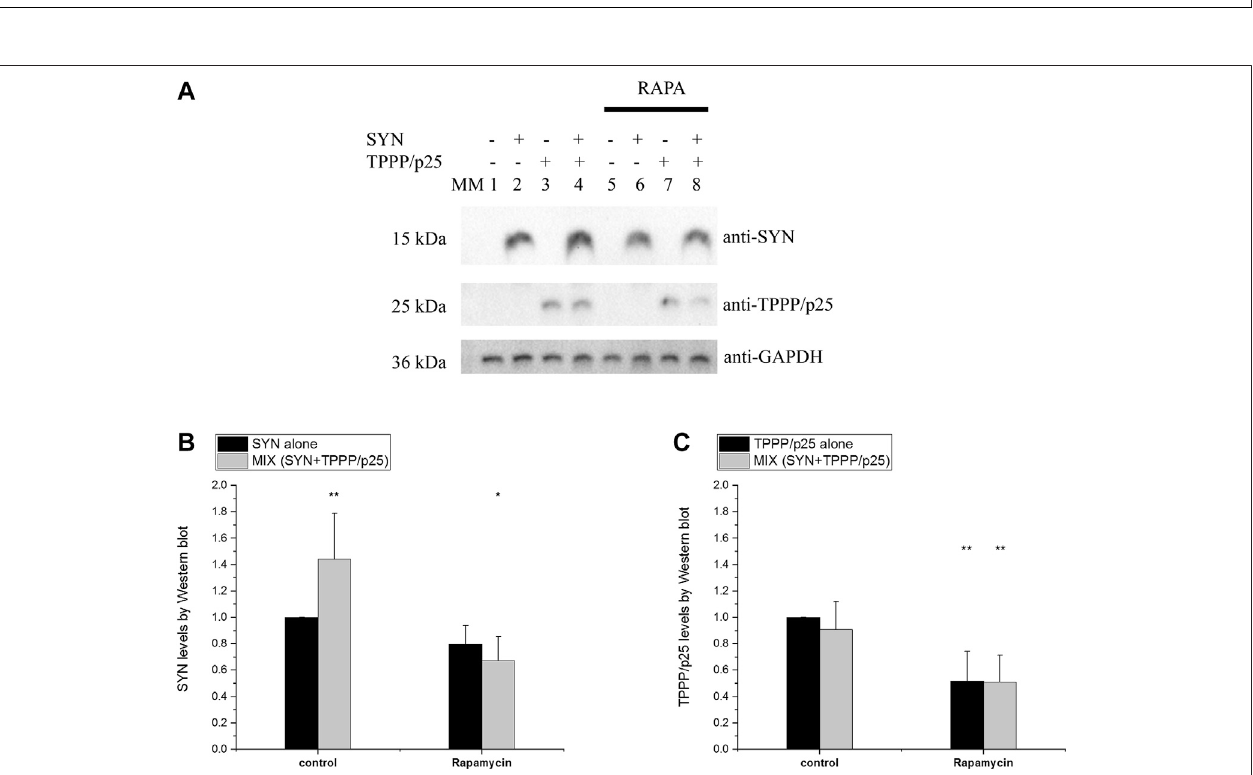
FIGURE 9 | Comparative studies: level of the degradation-resistant hallmark proteins in the course of autophagy in HeLa and SH-SY5Y cells. TPPP/p25 and/or SYN at 80 nM and 800 nM concentrations, respectively, were added to the medium of SH-SY5Y cells. Other conditions are the same as described in the legend of Figure 7 . The concentration of rapamycin (RAPA) is 1 μ g/ml. (A) Representative Western blots. MM: molecular weight marker. (B – C) Quanti fi cation of the degradation- resistantSYN (B) andTPPP/p25 (C) andtheirassembliesincells.Dataarenormalizedwithrespecttotheaddedhallmarkproteinalone(B:SYN,C:TPPP/p25),and presented as the mean ± SD of at least 4 independent experiments. Statistical comparisons were performed with one-way ANOVA followed by Tukey ’ s test (* p < 0.05 and ** p < 0.01 as compared to control).